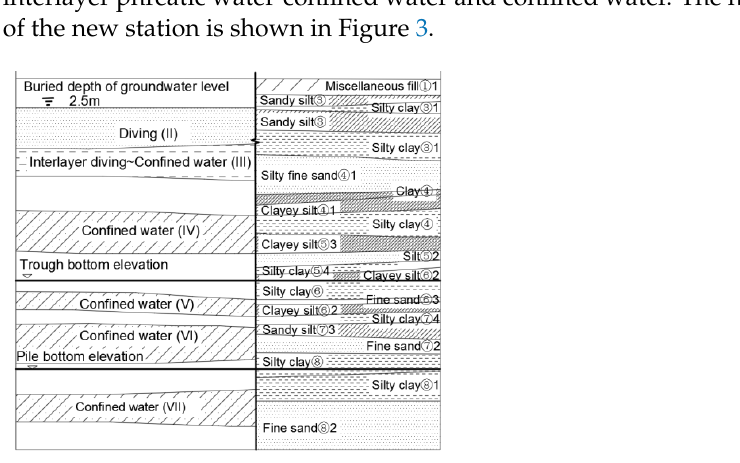
Figure 3. Hydrogeological profile.